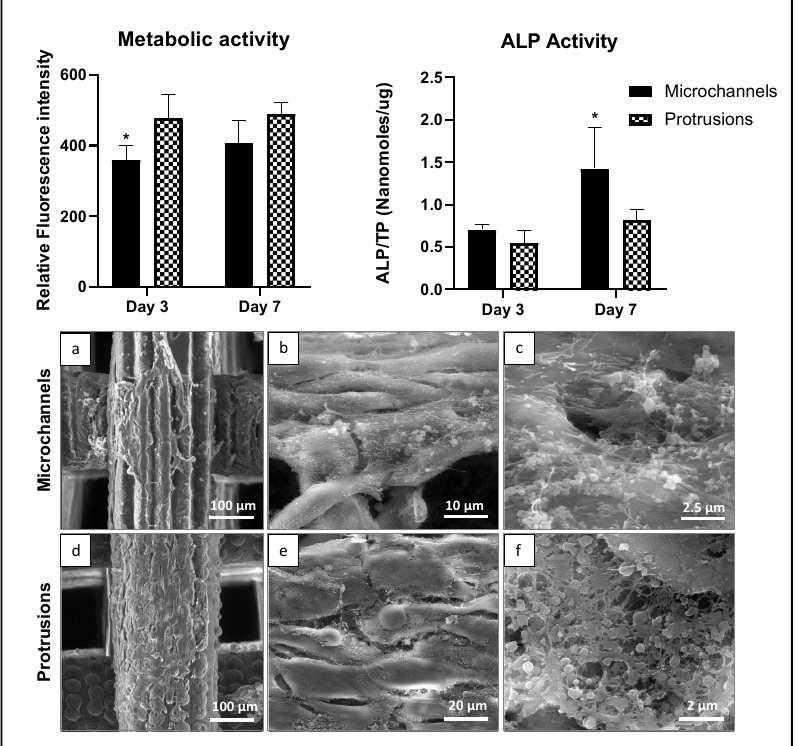
Figure 9. Metabolic activity (days 3 and 7), ALP activity (days 3 and 7), and SEM representative images (day 7) of human osteoblastic cells cultured over laser-induced topographies on PCL microchannels ( a – c ) and protrusions ( d – f ), in osteogenic conditions. Scale bar: 100 μ m ( a , d ), 10 μ m ( b ), 20 μ m ( e ), 2.5 μ m ( c ), and 2 μ m ( f ). * Significant difference from protrusions, p ≤ 0.05.